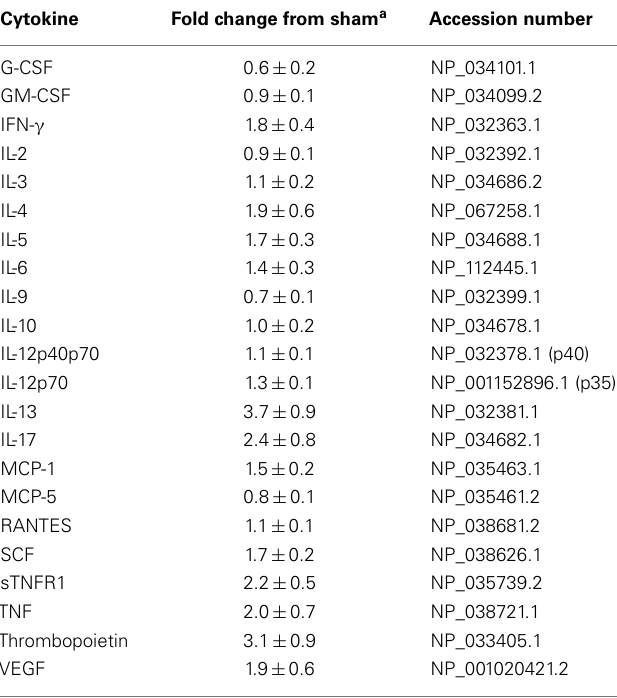
FIGURE 2 | Sections of human hearts with cardiomyopathy were stained with hematoxylin and eosin (H&E) or by immunofluorescence for the indicated markers .The white bars are 10 µ m.